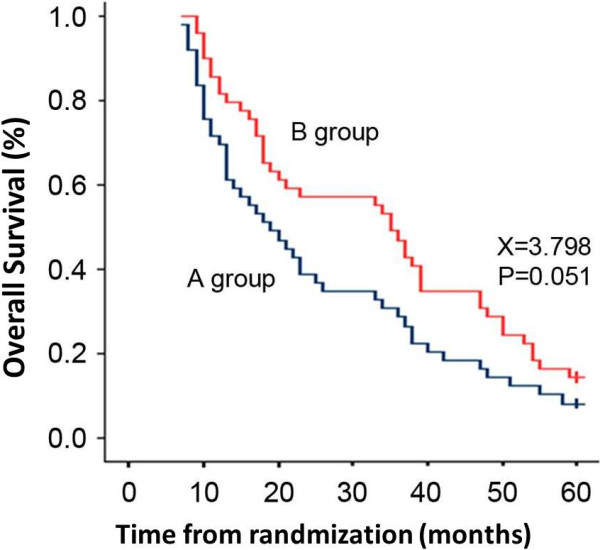
Comparison of the overall survival in both groups.